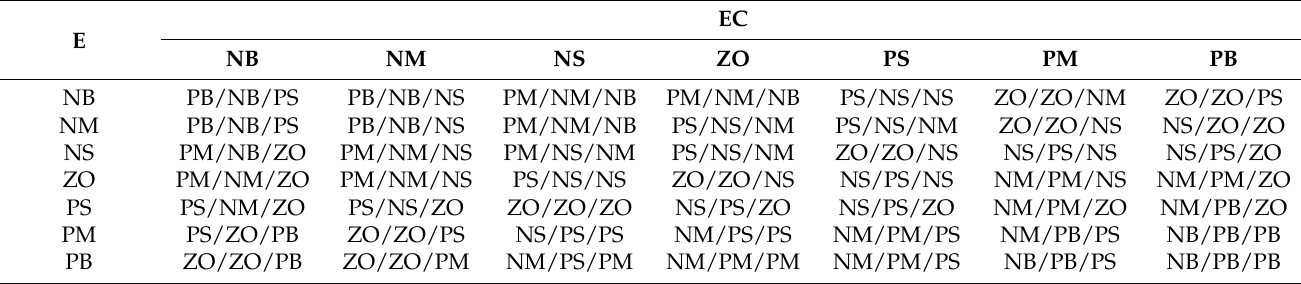
Table 2. Fuzzy PID control